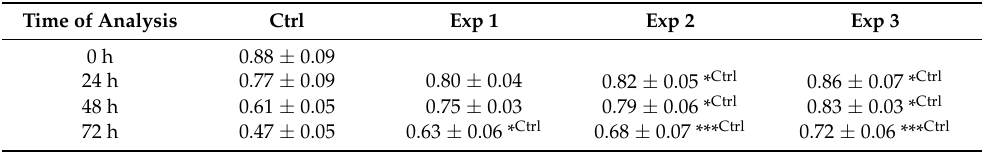
Table 5. Mitochondrial membrane potential of boar spermatozoa (JC-1 units) exposed to selected semen extenders during different time intervals.